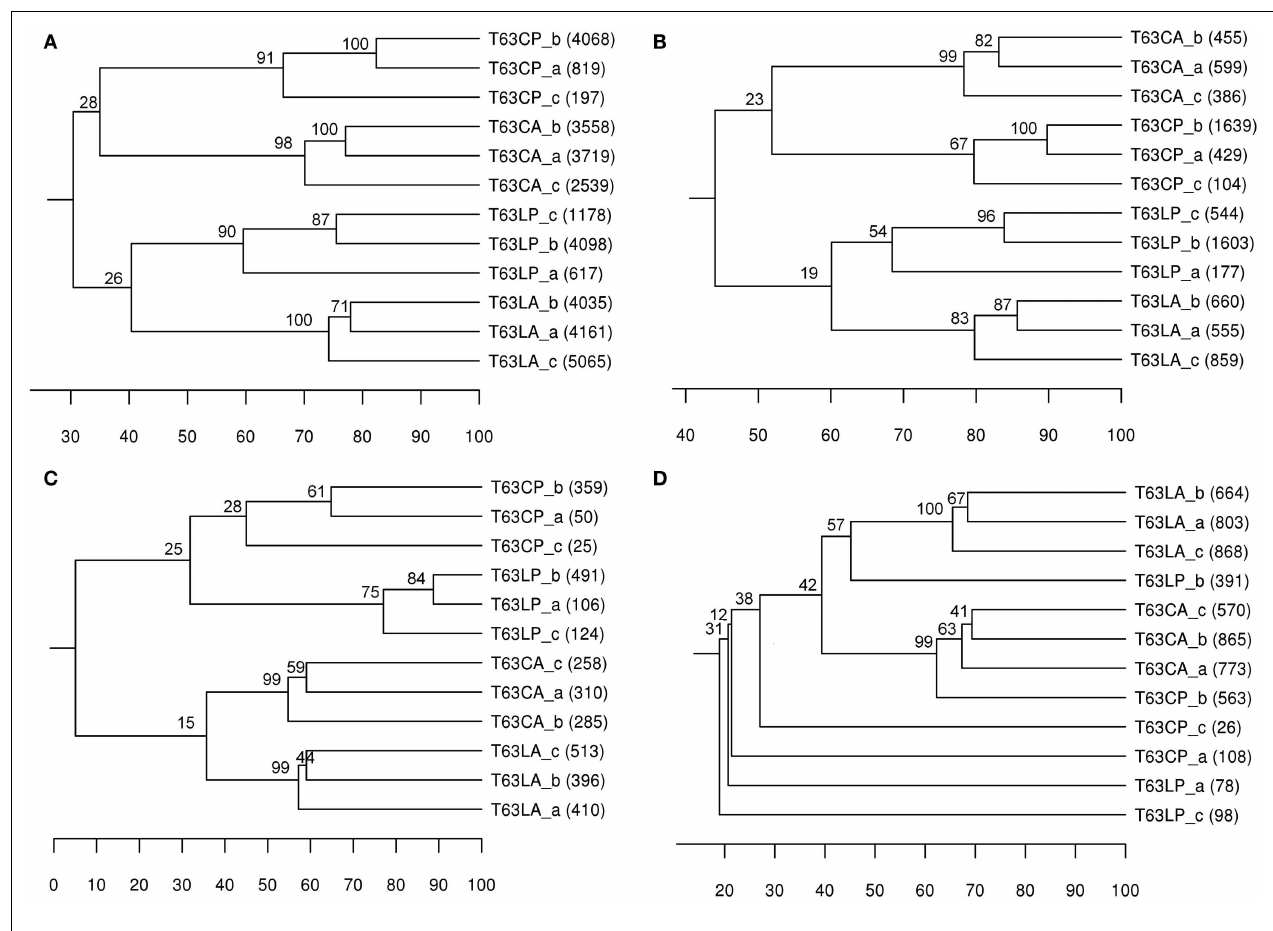
node grouping exclusively together. (A) total bacterial community; (B) Alphaproteobacteria ; (C) Betaproteobacteria ; (D) Actinobacteria .T63, 63days after phenanthrene spiking; CA: Cambisol control, CP: phenanthrene-spiked Cambisol, LA: Luvisol control, LP: phenanthrene-spiked